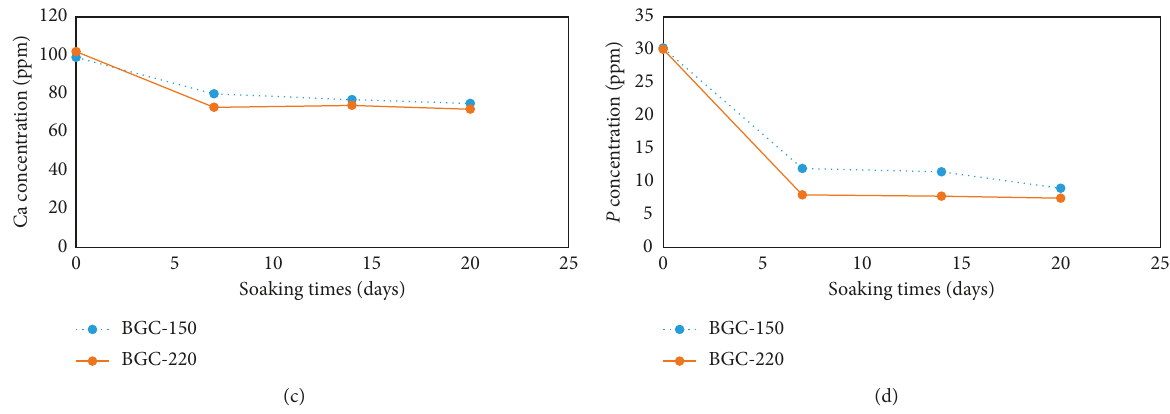
Figure 8: Evaluations of pH and Ca, Si, and P concentrations in the SBF solution after 0, 7, 14, and 20